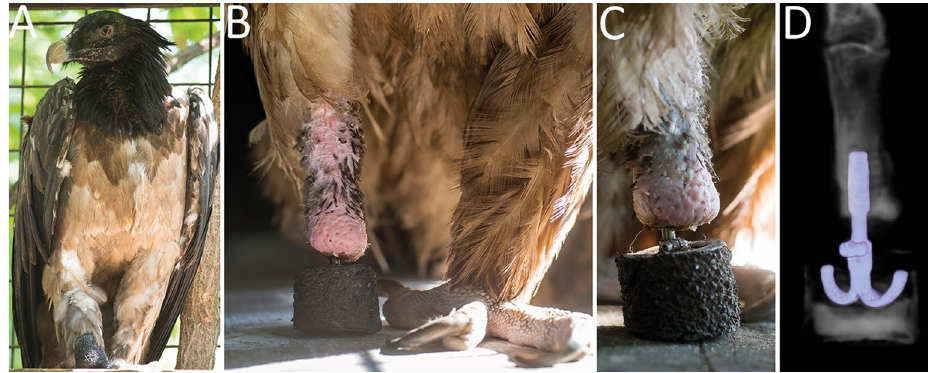
Figure 4. Postoperative images of the osseointegrated prosthesis. ( A ) The vulture shows a restored ability to stand and distribute weight on both extremities, preventing pressure-induced issues on the healthy limb. ( B ) Front view: The size and weight of the prosthesis is matched to the regular limb. Although the limb replacement does not contain the ability to grasp prey, the ability to maintain stance enables the bird to use the intact limb safely. ( C ) Side view: The prosthesis provides an irregular surface with traction and a shock-absorbing function by a specialized combination of materials for endurance and compressibility. Supplemental videos show the prosthesis in use during stance, gait and feeding. ( D ) A transparent osseous 3D model of the CT images demonstrates the situs and configuration of the